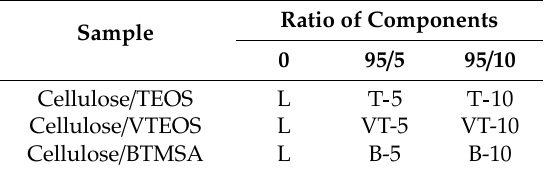
Table 2. Designation of the composite fibers.